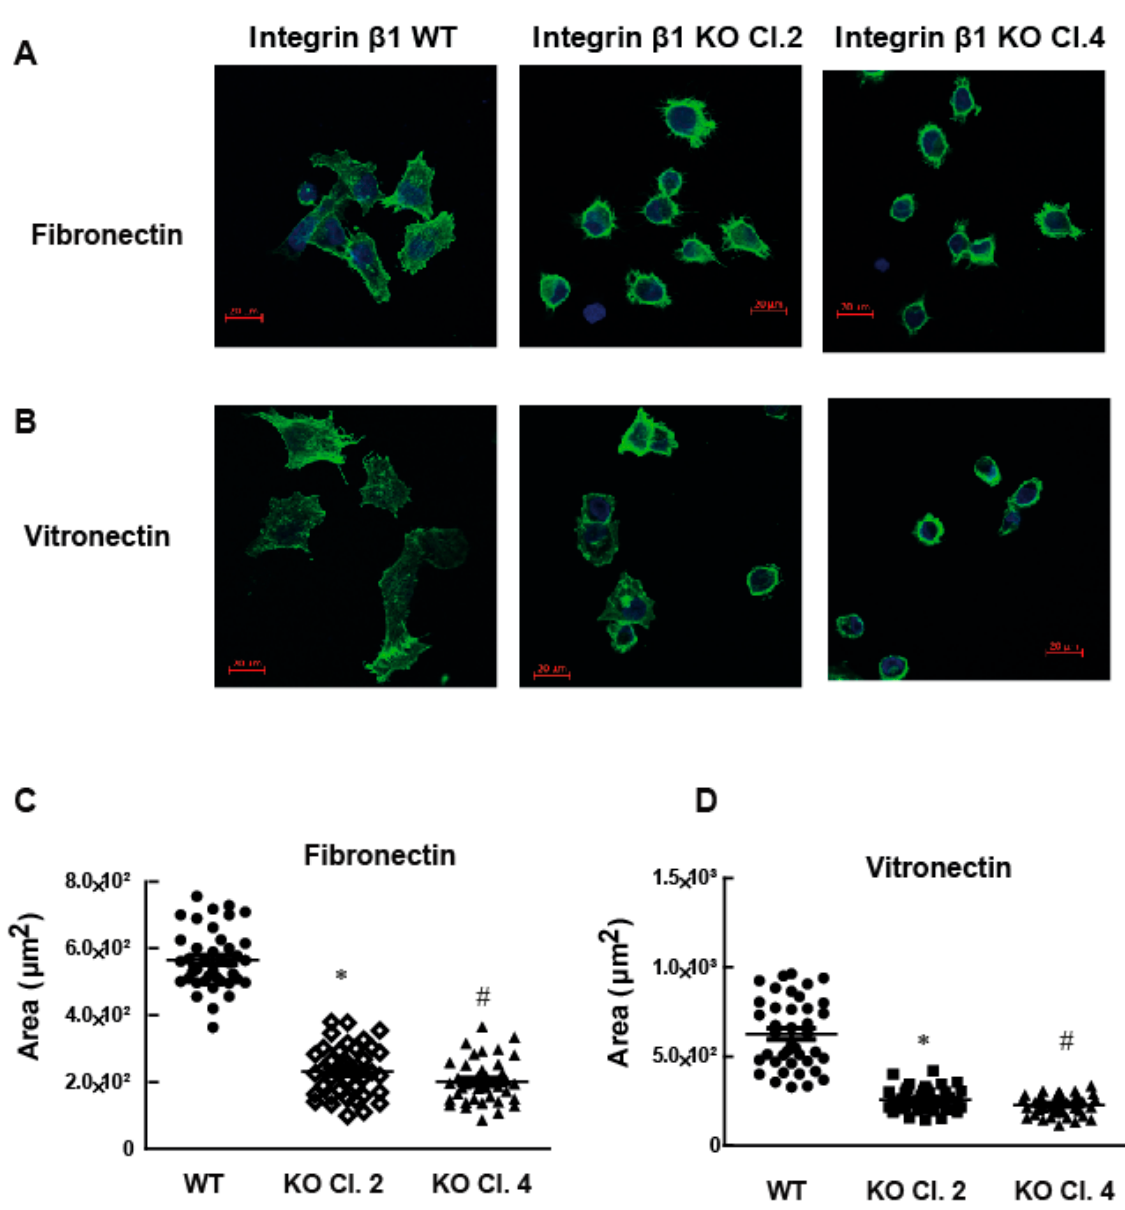
Figure 4. MIA PaCa-2 integrin β 1 KO cells have decreased spreading ability compared to integrin β 1 expressing cells. Cells were plated on either fibronectin or vitronectin coated plates for 4 h and the cells were stained with actin. ( A ) Actin staining of cell spread on 5 µ g/mL fibronectin visualized by immunostaining (F-actin, phalloidin, green; and nucleus, DAPI, blue). Scale bar 20 µ m. ( B ) Actin staining of cell spread on vitronectin visualized by immunostaining (Green: F-actin using phalloidin, and Blue: nucleus DAPI). Scale bar 20 µ m. ( C , D ) Quantitative assessment of cell spreading in fibronectin (area: µm 2 ). One-way ANOVA was performed with Bonferroni’s post-hoc test to compare between groups. * Indicates a statistically significant difference between groups (integrin β 1 expressing MIA PaCa-2 and integrin β 1 KO Clone 2) ( n = 40, p < 0.001). # Shows a statistically significant difference between groups (integrin β 1 expressing MIA PaCa-2 and integrin β 1 KO Clone 4) ( n = 40, p < 0.001). Data shown are mean ± SEM, unit: µm 2 .